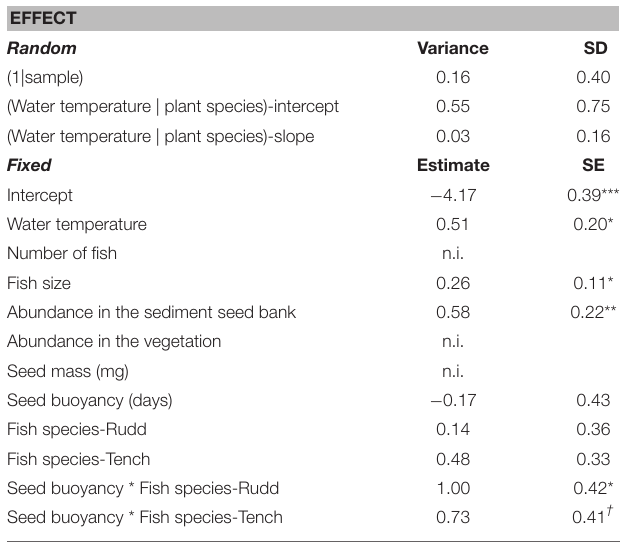
TABLE 2 | Coefficients and their significance of the binomial GLMM-model best explaining the presence of plant species (as a viable seed) in feces of Rudd, Roach, and